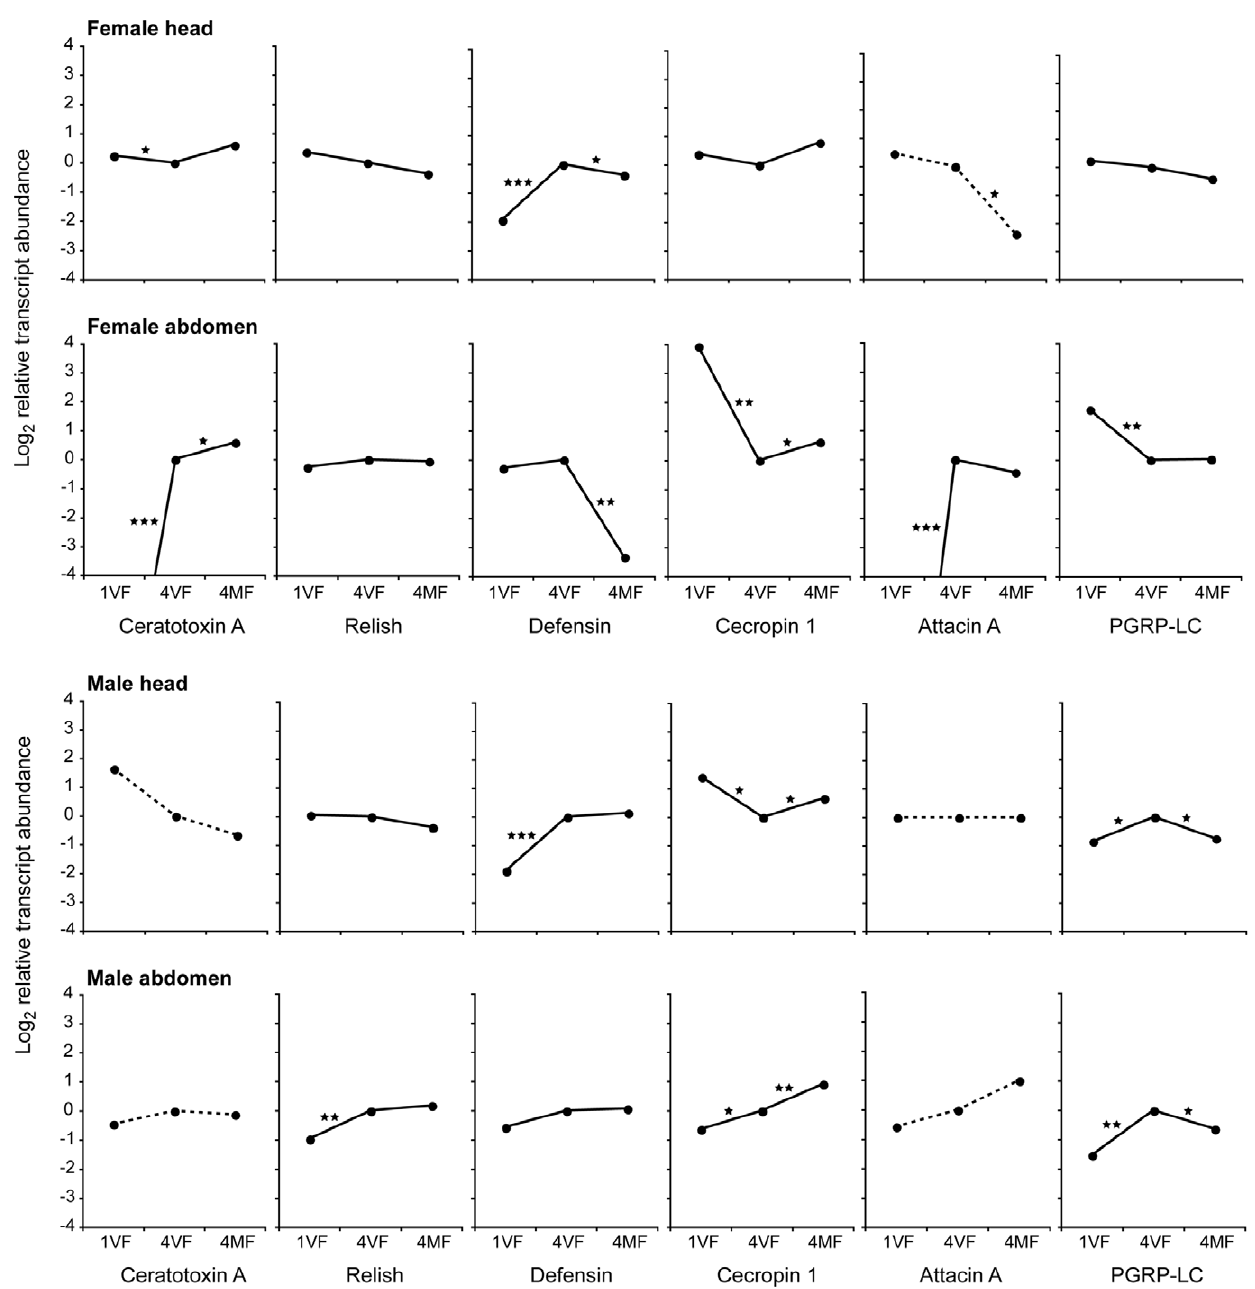
Figure 2. Differential transcript levels (Log 2 transformed fold changes) of six immune genes in sexually immature, mature virgin, and mated medfly, compared to mature virgin medfly transcript levels. Transcript abundances were determined in immature (1V), mature virgin (4V) and mated (4M) female (upper) and male (lower) medfly heads and abdomens. Transcript abundances are expressed as ratios are compared to mature virgin levels (4V). Broken lines indicate that transcript abundances were very low. Stars indicate significant difference in transcript abundances (*P , 0.05, **P , 0.01, ***P , 0.001, two-tailed t -test on three replicates) in the pairwise comparison between immature and mature virgin flies, or mature virgin and mated flies. Lines between data points are purely for ease of graphical interpretation and do not imply a continuous relationship between data points. doi:10.1371/journal.pone.0030857.g002 Upon mating, only Ceratotoxin A and Cecropin 1 showed significant, female head, compared to virgin females, although the extent was but very modest increases in transcript abundance in the female difficult to quantify due to the very low transcript abundance abdomen (1.5-fold). The only other immune-related genes to show (Figure 2). In mated males there was a modest increase in the Cecropin 1 transcript abundance in the head and abdomen (1.6- and significant changes in transcript abundance after mating in the female were Defensin which was less abundant, particularly in the 1.9-fold respectively) and a decrease in PGRP-LC abundance in both abdomen (10-fold), and Attacin A that was less abundant in the body compartments (1.6- and 1.7-fold) compared to virgin males.